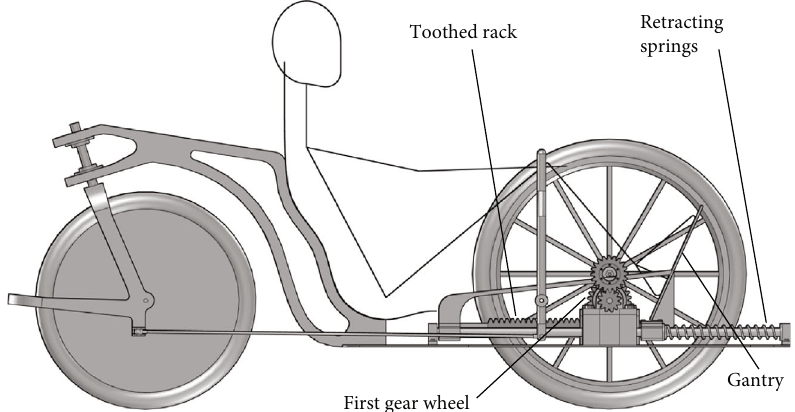
Figure 2: The gantry used in the horizontal bike (side view).